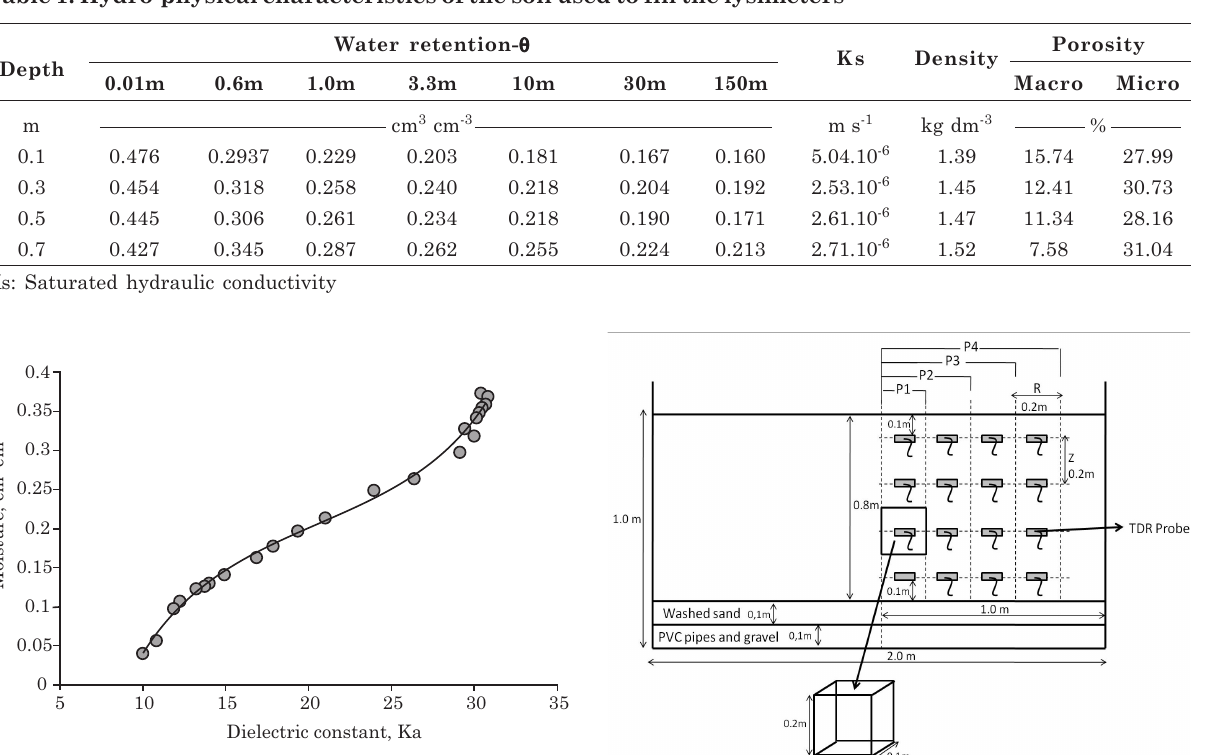
Figure 1. Relationship between soil moisture θθθθθ and dielectric constant Ka, for the soil used in the experiment.